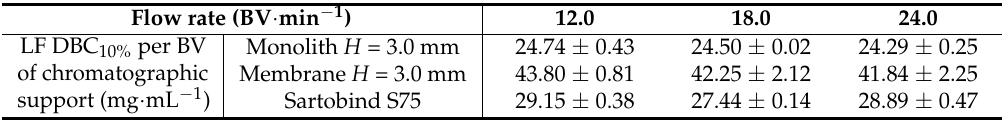
Table 2. Dynamic binding capacity of LF at 10% breakthrough (DBC 10% ) of LF per BV using membrane and monolith supports at a BSA-LF loading ratio of 2/1 diluted in 100 mM phosphate buffer at pH 6.0 and the flow rates of 12.0, 18.0 and 24.0 BV·min − 1 .